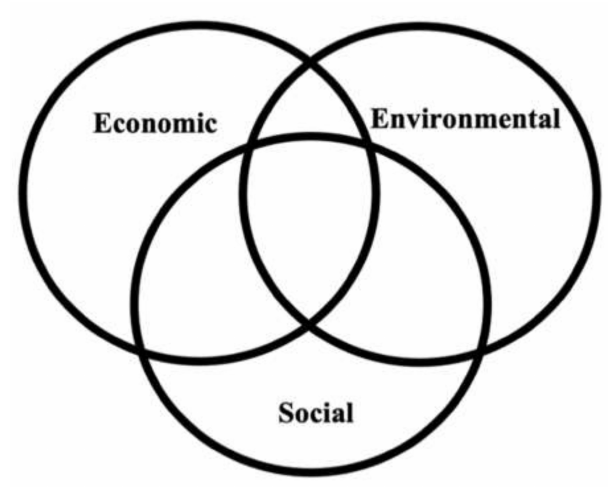
Figure 1. Standard concept map of factors involved in